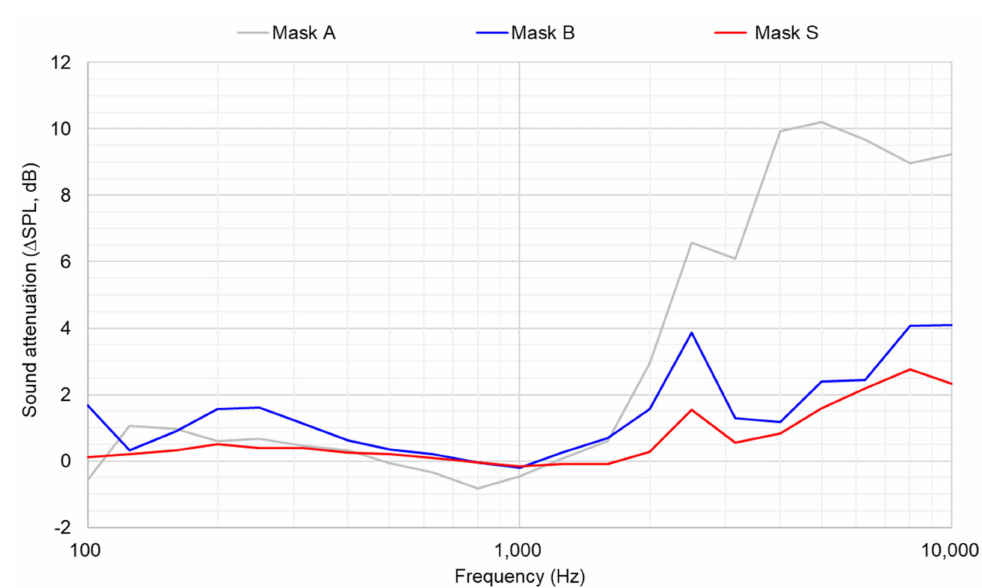
Figure 5. Spectral distribution of sound attenuation ( ∆ SPL) for the three face masks.